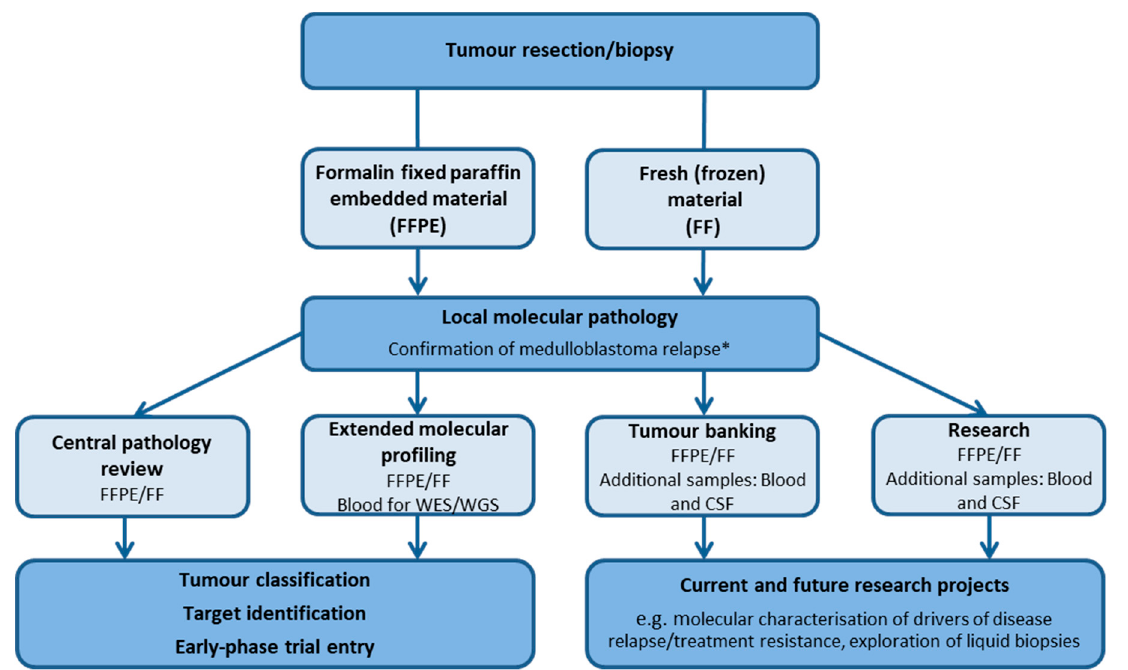
Figure 3. Schematic representing sample considerations following neurosurgical resection/biopsy at relapse. * Confirmation of relapse requires central pathology review and molecular profiling such as DNA methylation array as part of a central review process according to national set-up. WES, whole-exome sequencing; WGS, whole-genome sequencing; CSF, cerebrospinal fluid.